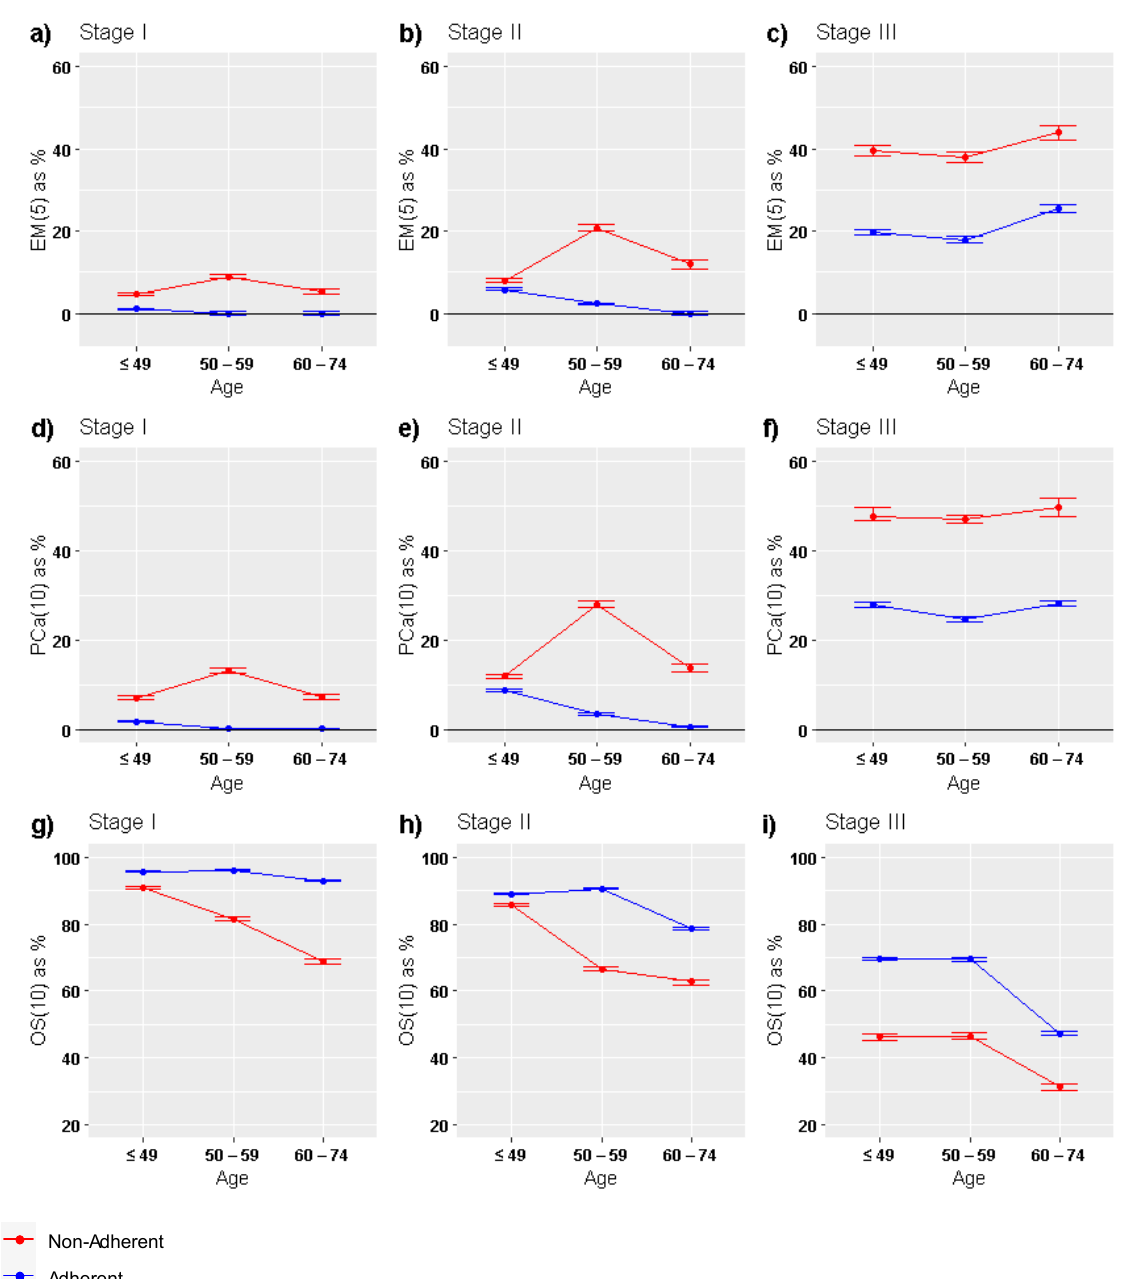
Figure 5. Graphical comparison of main population-based survival indicators between adherent and nonadherent BC patients across age groups: ( a – c ) EM(5); ( d – f ) PCa(10); ( g – i ) OS(10). EM(5): 5-year conditional excess mortality (EM) at T = 5 years after cancer diagnosis; PCa(10): crude probability of death due to cancer at T = 10 years; OS(10): observed survival at 10 years after cancer